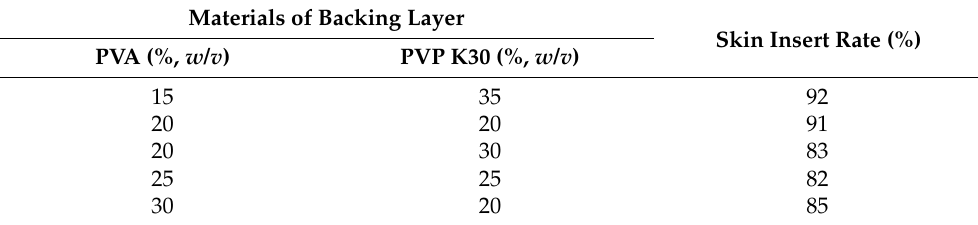
Figure 3. ( a ) Diffusion of the backing layers of different materials (( i ) 20% PVA + 30% PVP K30; ( ii ) 30% PVA + 20% PVP K30; ( iii ) 20% PVA + 20% PVP K30 ( w / v )); ( b ) CUR-NCs diffusion ( i ) and without diffusion ( ii ) in backing layers (red arrow—diffusion, white arrow—without diffusion). Table 1. Different backing materials and the skin insert rates of MNs.